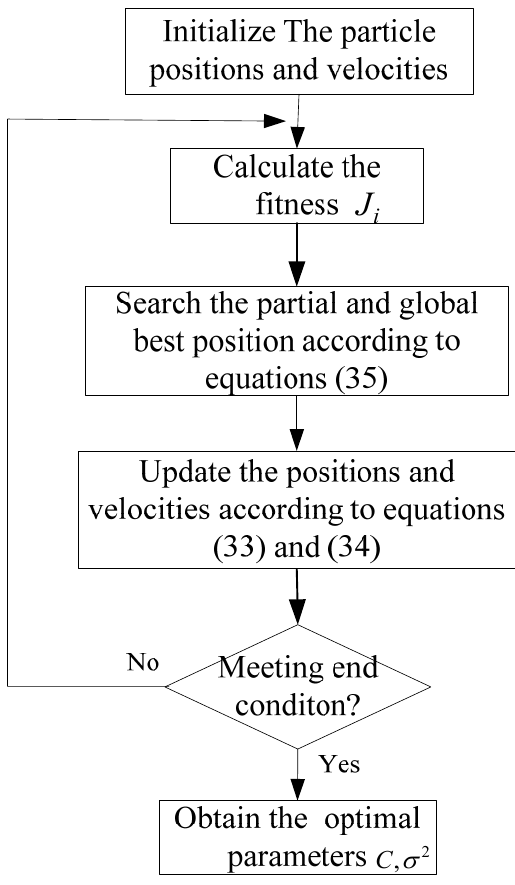
Figure 4. The parameters optimization process of the LSSVR based the PSO